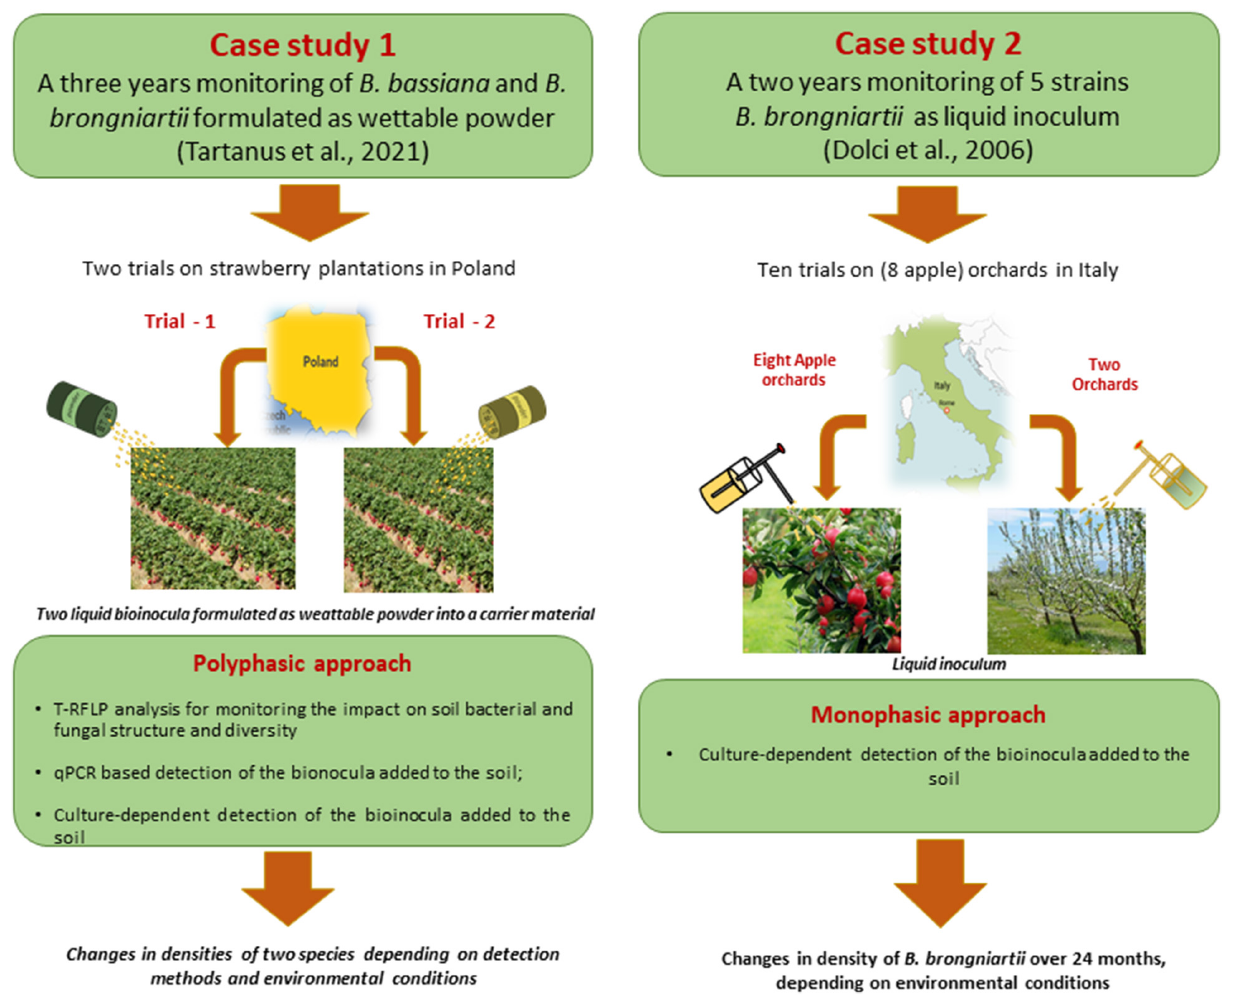
FIGURE 5 | Two case studies of different methods for detection and monitoring of inoculum